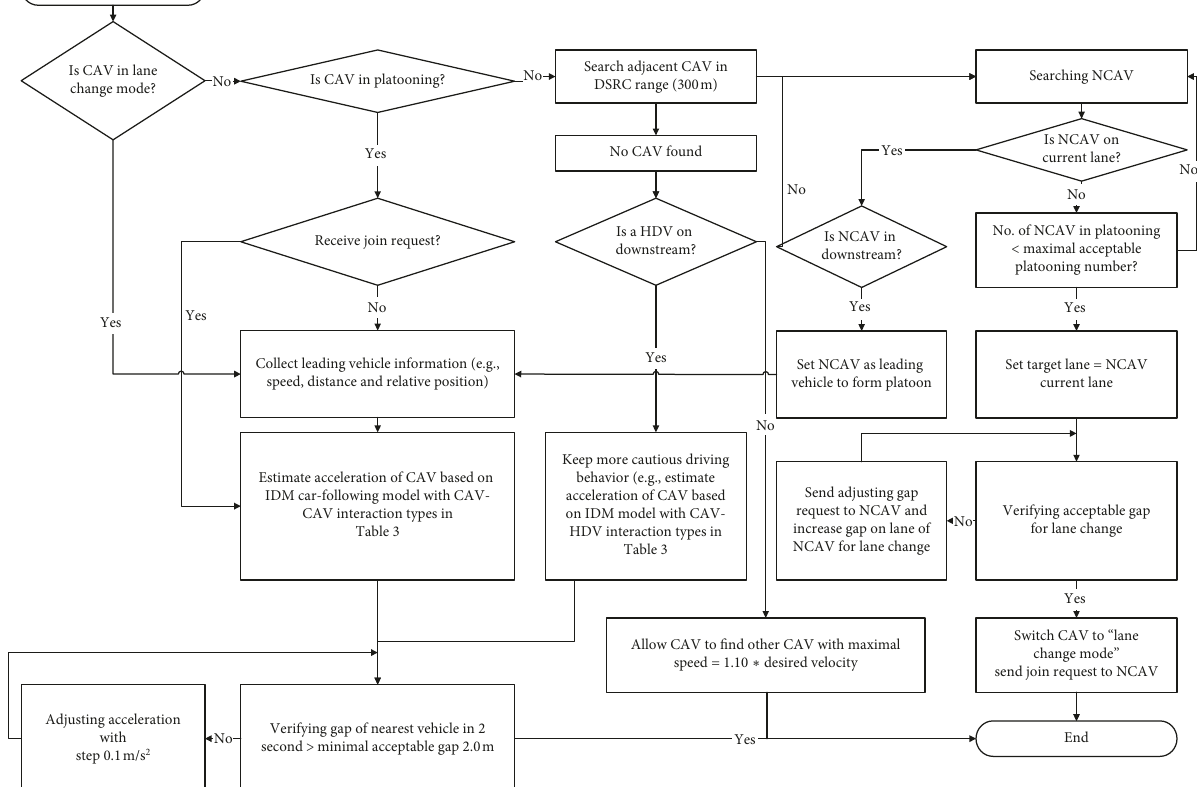
Figure 2: Platoon controlling algorithm for